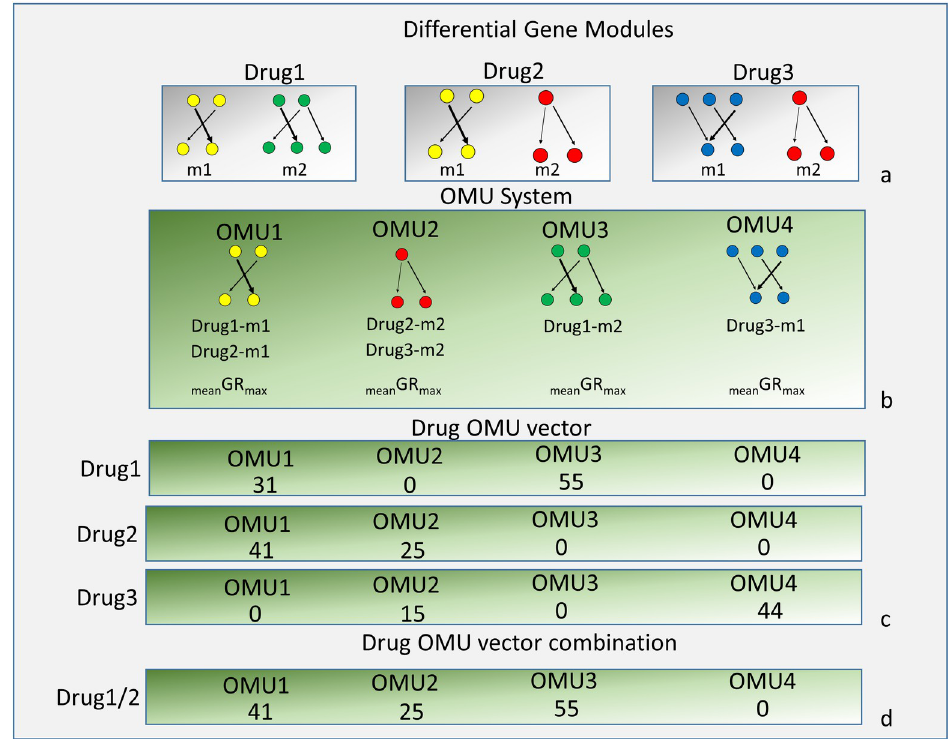
Fig 2. Flow chart to construct the OMU system and drug OMU vectors. (a) Modules of the drug (b) Structure of the OMU system (c) Drug OMU vector (d) Combine two drug OMU vector.